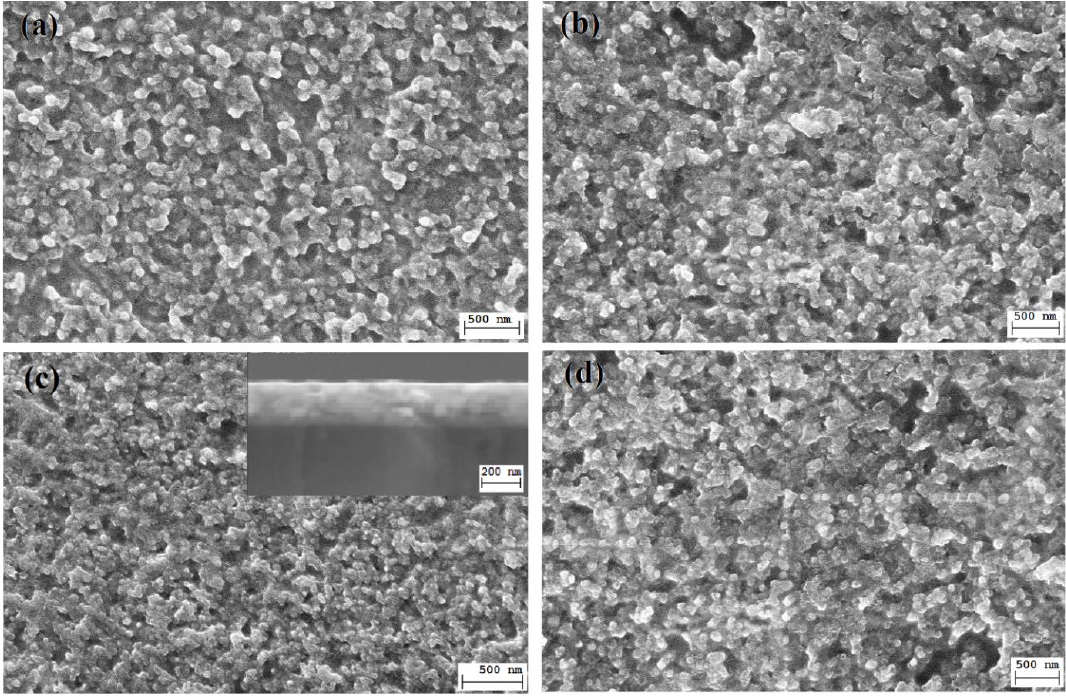
Fig. 1. SEM images of (a) BSO, (b) BSS1, (c) BSS2; the inset shows the cross section, and (d) BSS3 thin films annealed at 700°C for